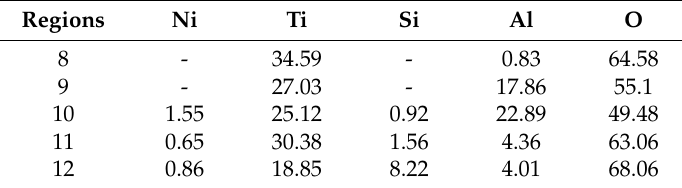
Figure 14. SEM morphologies of the substrate ( a , b ) and coating 4 ( c – e ) exposed at 800 °C for 50 h. Table 4. EDS analysis results of the regions in substrate and coating 4 after oxidation test (at %). Regions Ni Ti Si Al